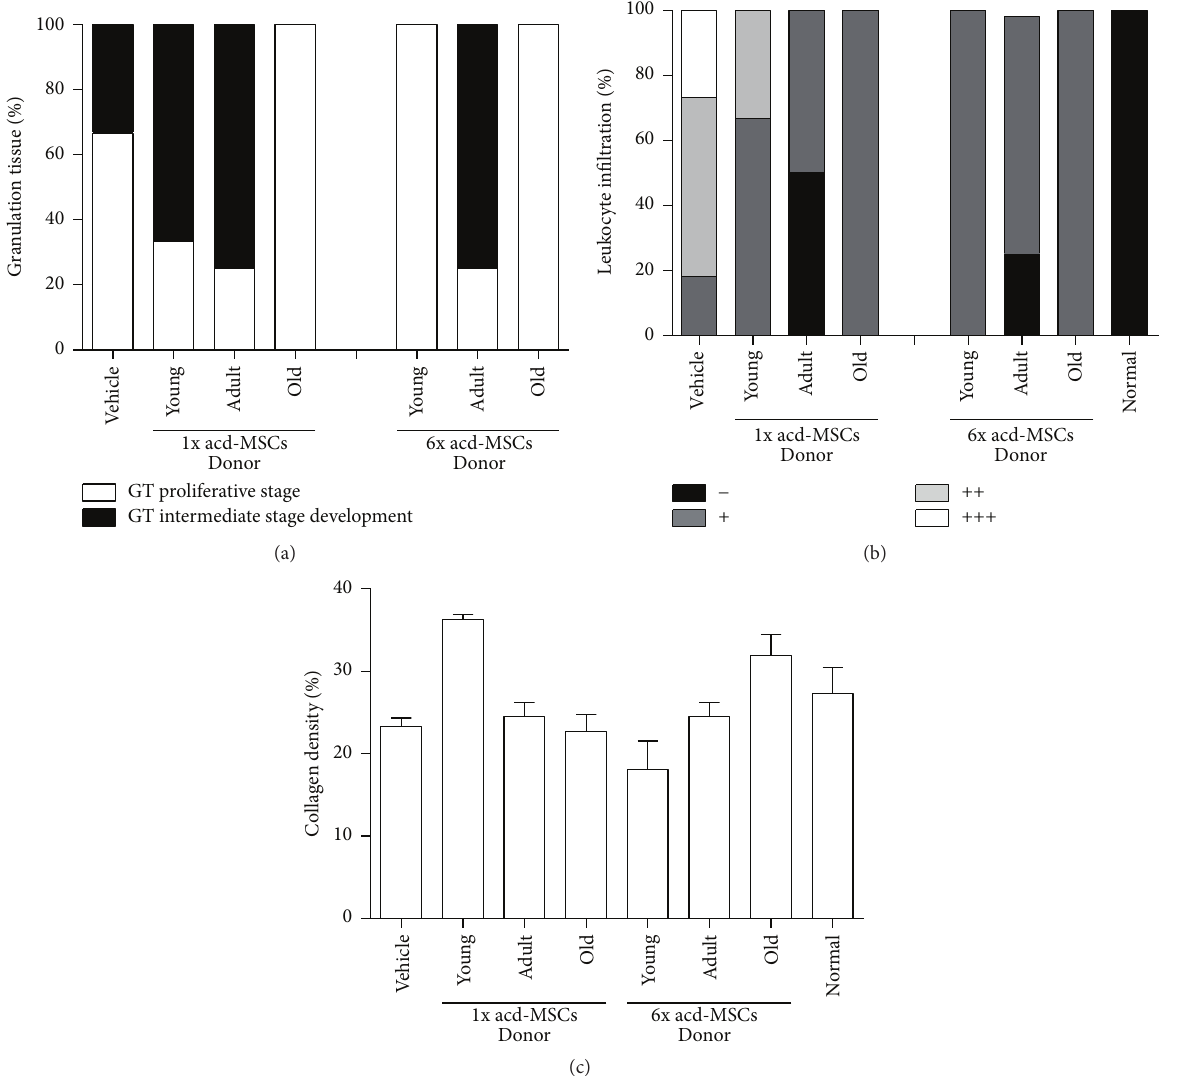
Figure7:acd-MSCsledtoskinhealingprocess.Frequency(%)ofanimalswithdifferenthistologicalscoresof(a)granulationtissueformation type, (b) leukocyte infiltration in the dermis, and (c) quantitative analysis of density of dermal collagen fibers. Representative results for 6–12 animals per experimental